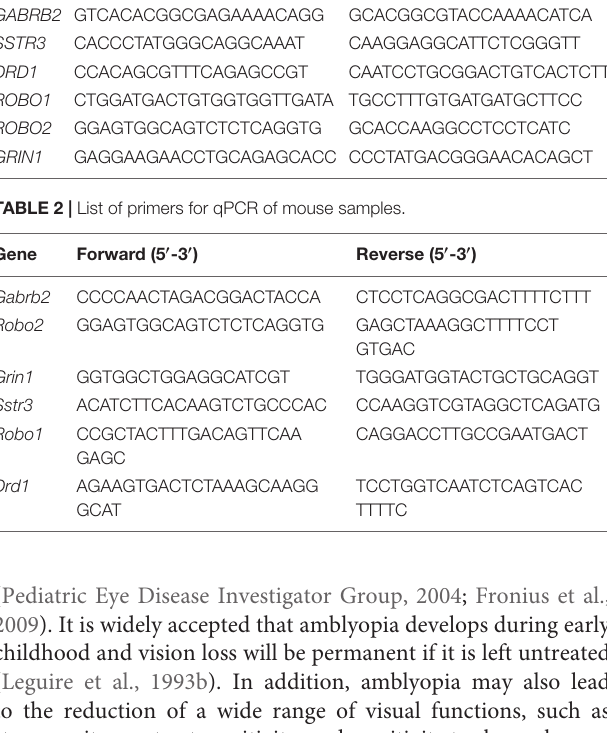
Frontiers in Neuroscience |